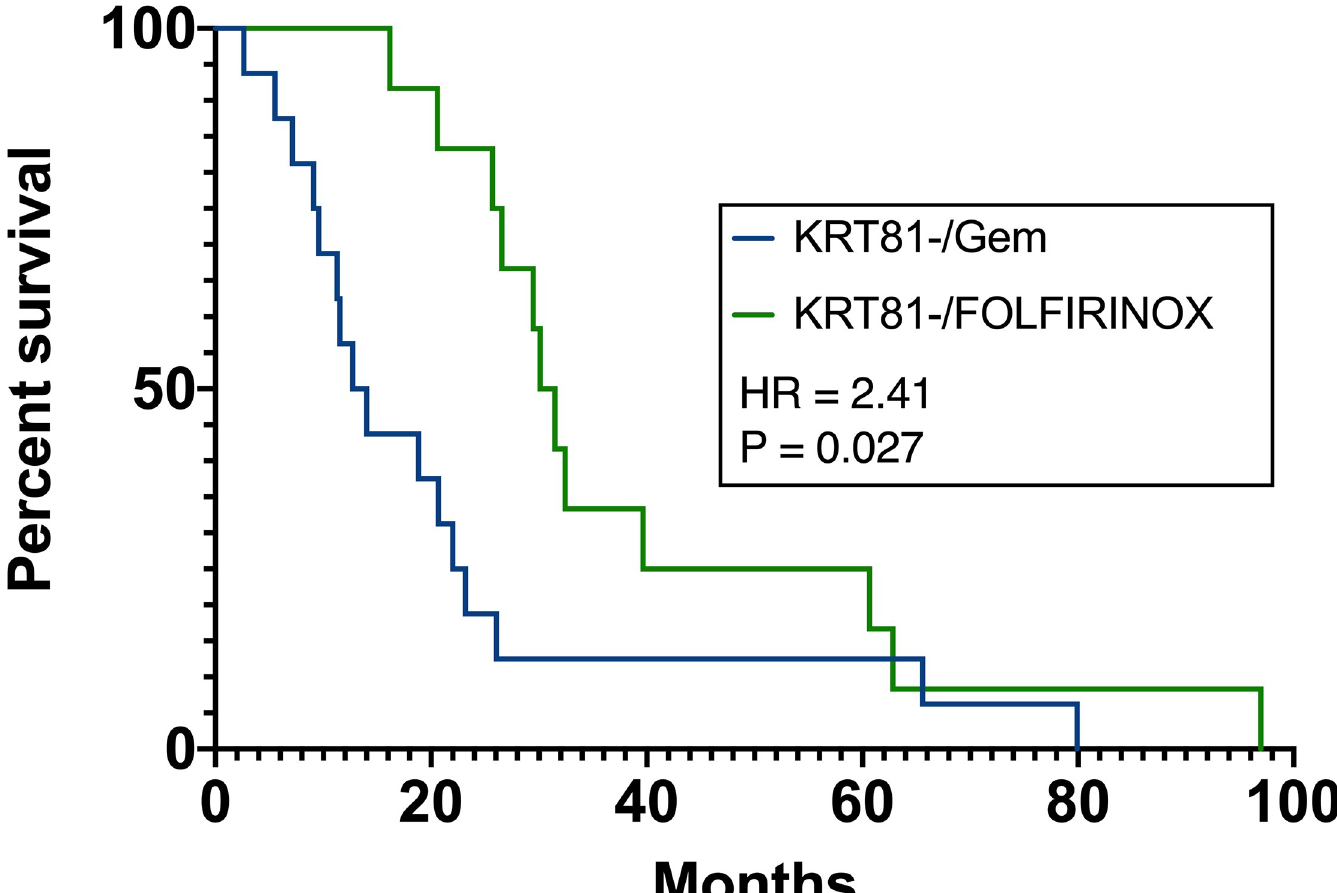
Fig 9. Patients with KRT81- subtype experience improved survival under palliative FOLFIRINOX